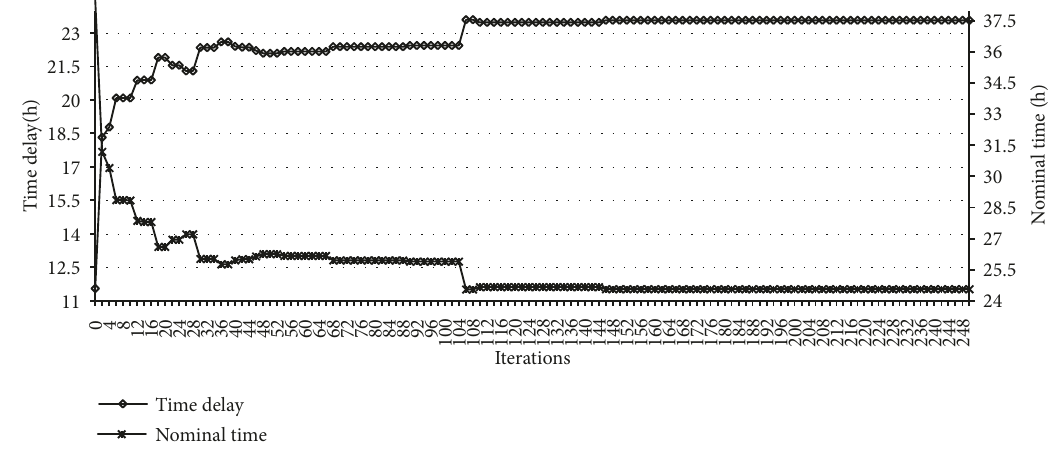
Figure 12: The convergence procedure based on time delay and nominal